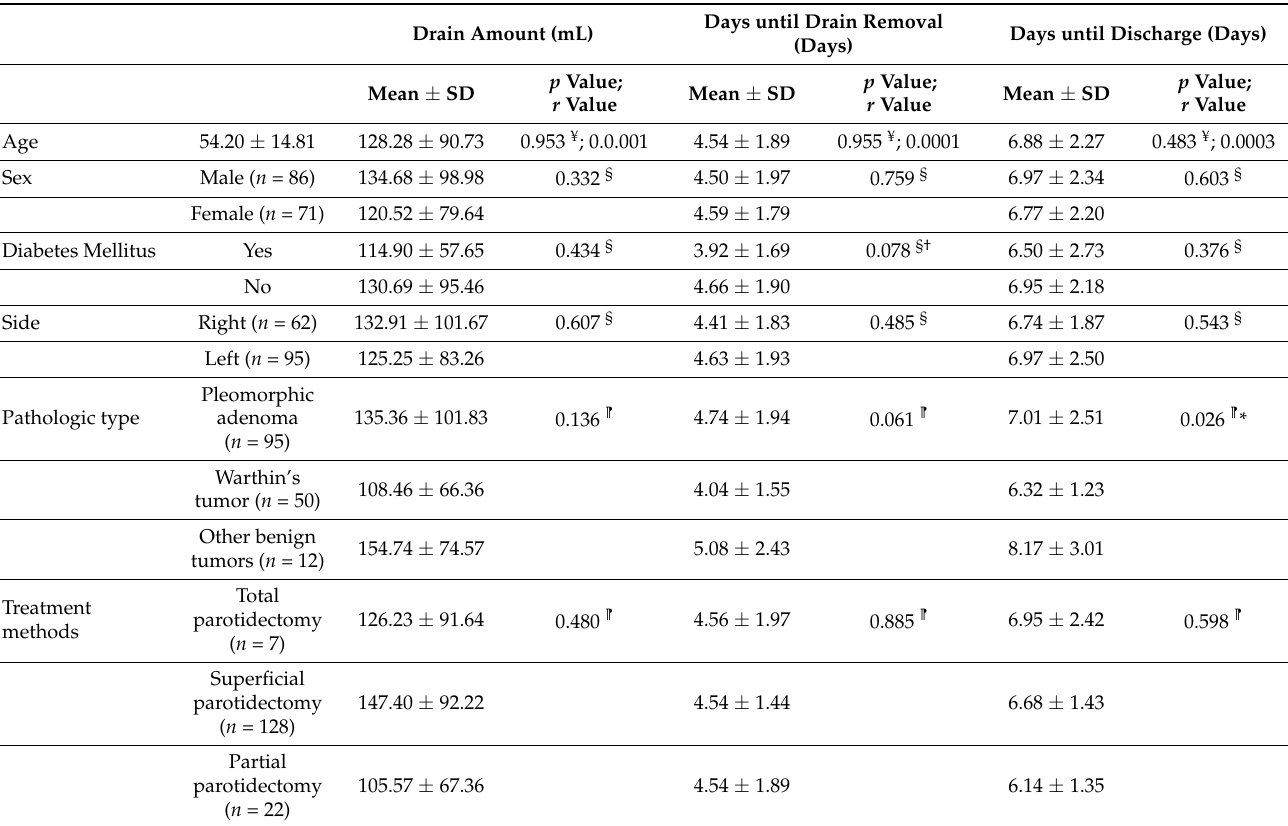
Table 2. Associations between baseline characteristics and primary outcome variables.